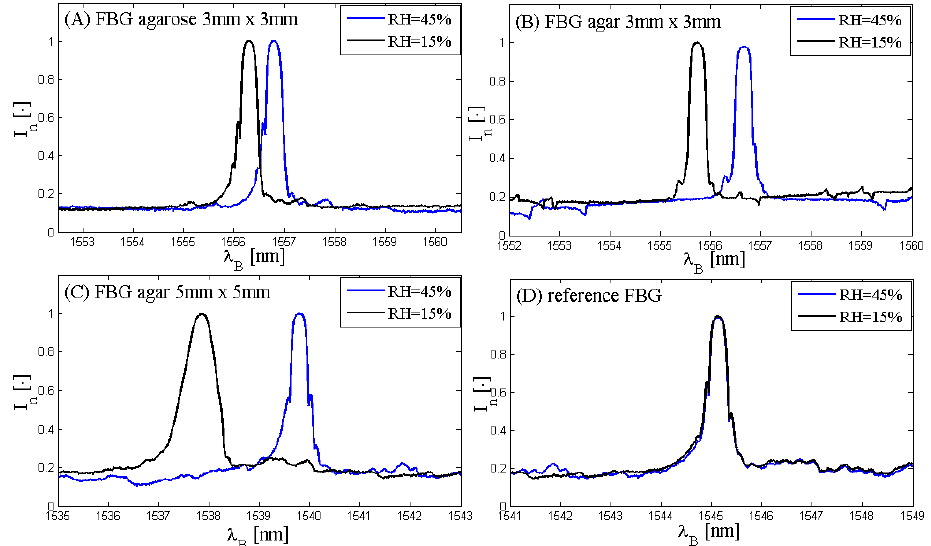
Figure 3. Spectra of the three fiber Bragg grating (FBG)-coated sensors and of the reference FBG sensor at different RH values: ( A ) spectra of the agarose 3 mm × 3 mm-coated FBG at RH = 15% (black line) and RH = 45% (blue line); ( B ) spectra of the agar 3 mm × 3 mm-coated FBG at RH = 15% (black line) and RH = 45% (blue line); ( C ) spectra of the agar 5 mm × 5 mm-coated FBG at RH = 15% (black line) and RH = 45% (blue line); ( D ) spectra of the reference FBG at RH = 15% (black line) and RH = 45% (blue line).